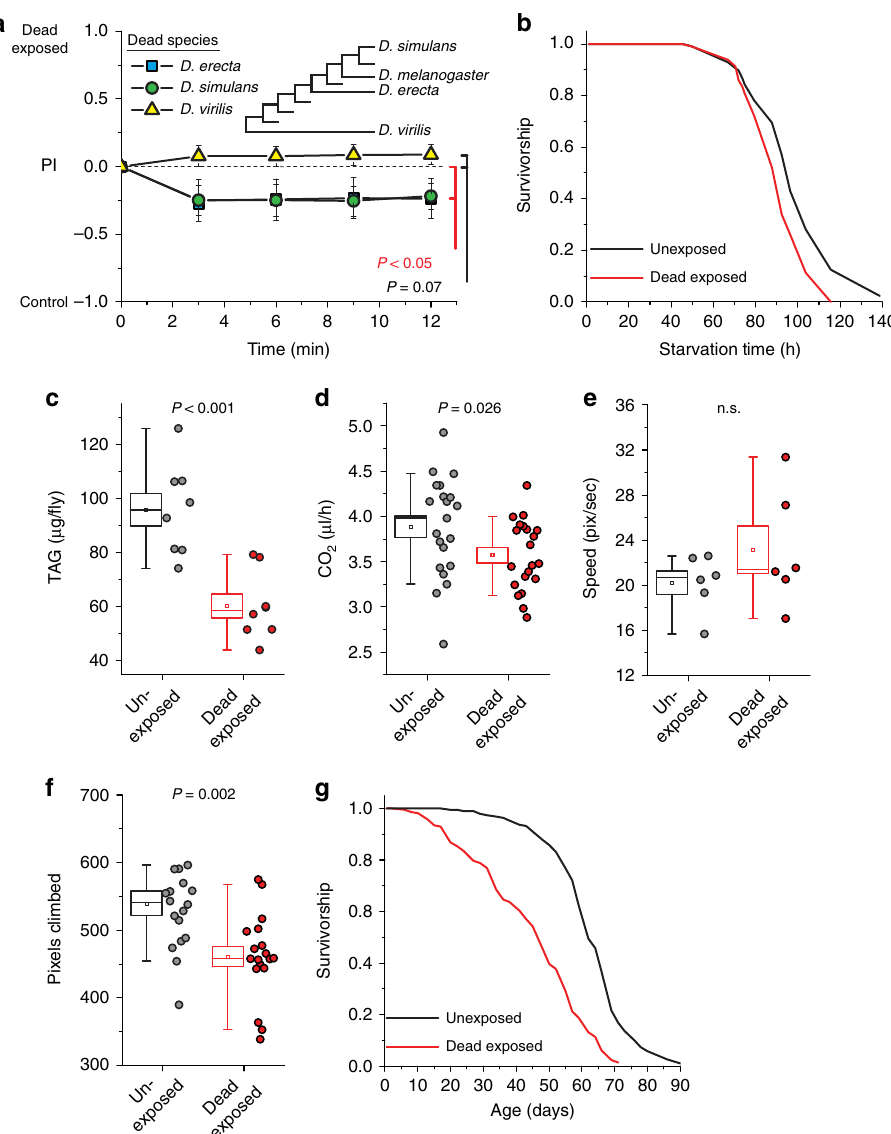
Fig. 2 Exposure to dead conspeci fi cs alters physiology and lifespan in Drosophila melanogaster . a When D. melanogaster were exposed to dead animals